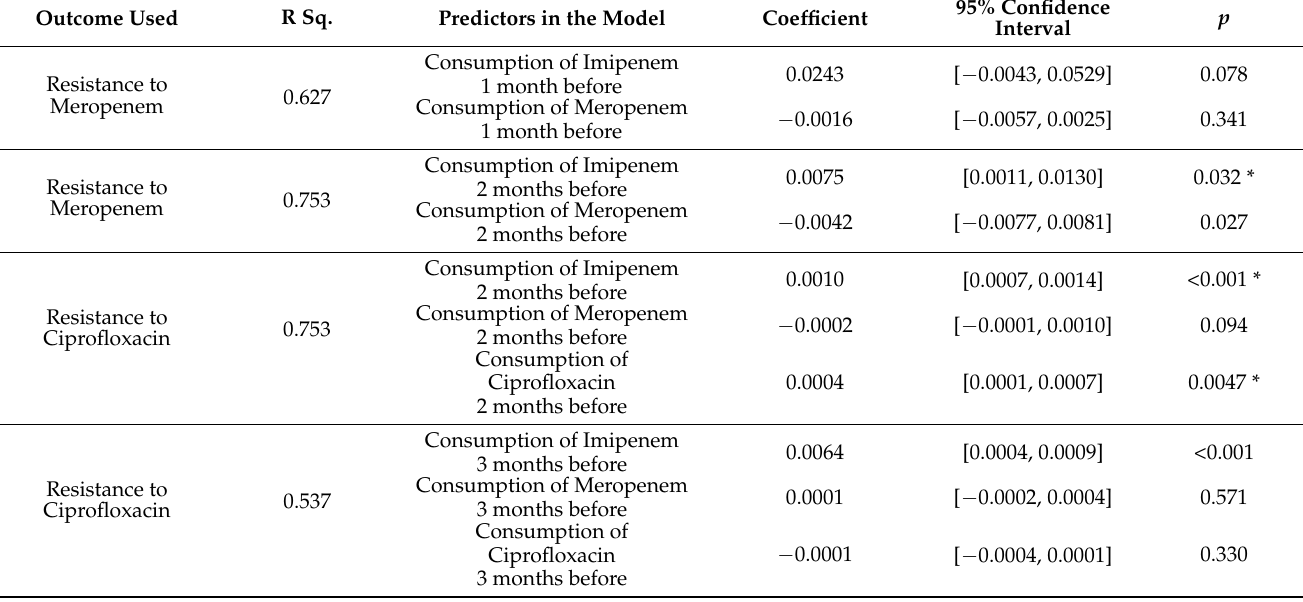
Table 6. Time-series regression analysis of correlations between meropenem and Ciprofloxacin resistance in Klebsiella and antibiotic